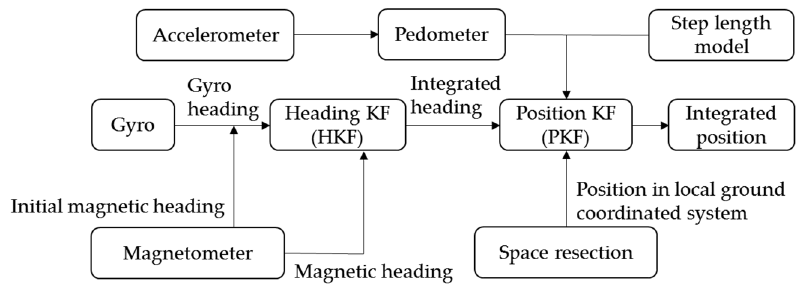
Figure 6. The proposed space resection-aided PDR.